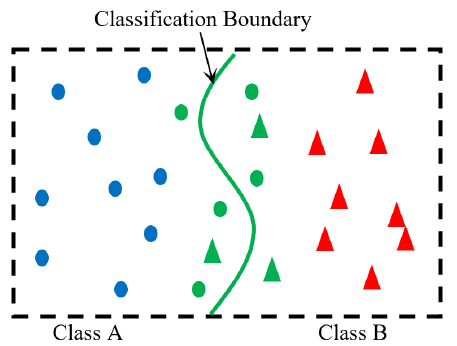
Figure 1. Diagram of a corner case. The two classes of data are colored as blue and red. Data of corner case is colored as green, which includes incorrectly classified data as well as data close to classification boundary which is sensitive to cause unexpected